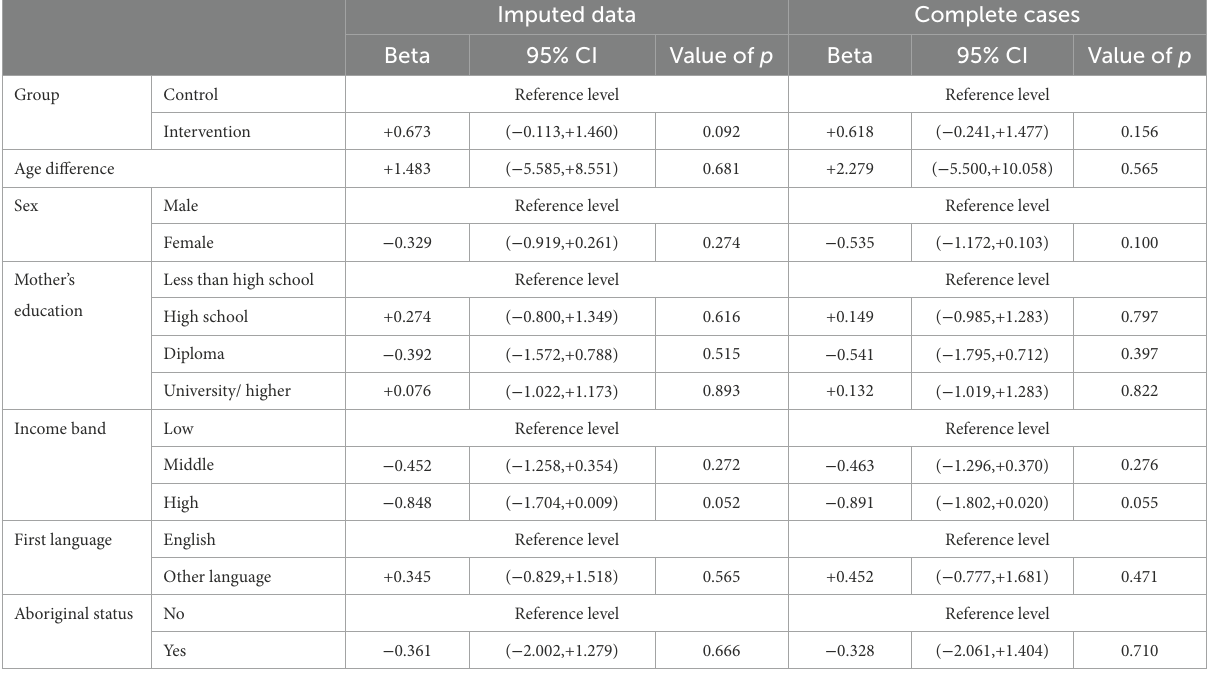
TABLE 9 Results of the regression model of difference between pre-and post-intervention DAS verbal comprehension scores; models fitted to multiply imputed data ( N = 1,130) and to complete cases only ( N =